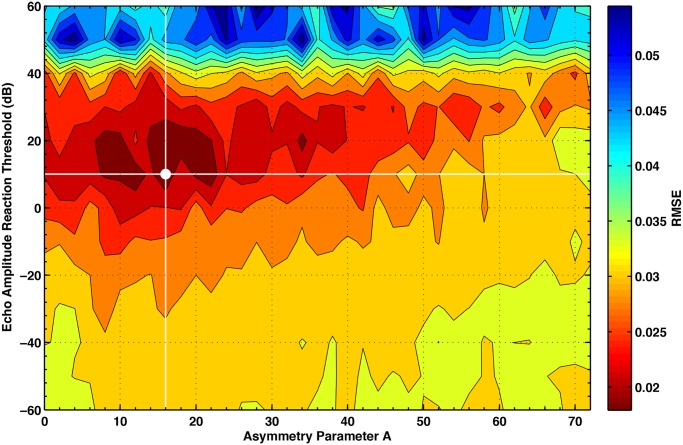
Fit of the model output to the observed interacting flights.Contour level plot representing the fit of the coordinated flight movement patterns with those obtained from the model. The fitting procedure consists of comparing the relative position plot of coordinated flights from Fig. 2A and from the model with 1.5 × 1.5 m2 resolution. For each grid square (i, j) the normalised probability density, (i, j) is calculated and the lowest mean square error obtained via the expression . The best fit is marked by the white point and corresponds to the model interaction field with parameters A = 16 and B = 10 dB.